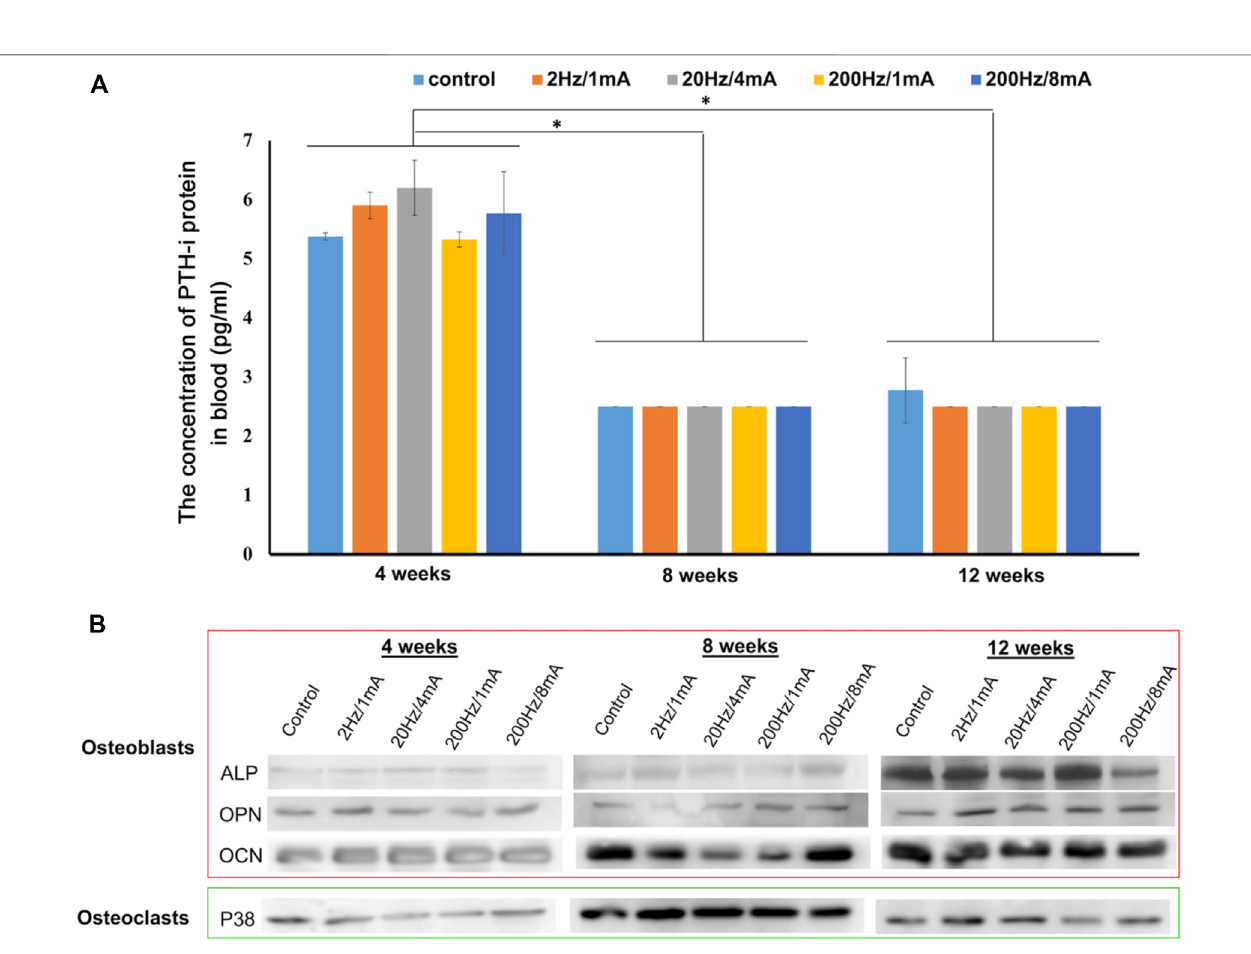
Frontiers in Bioengineering and Biotechnology |